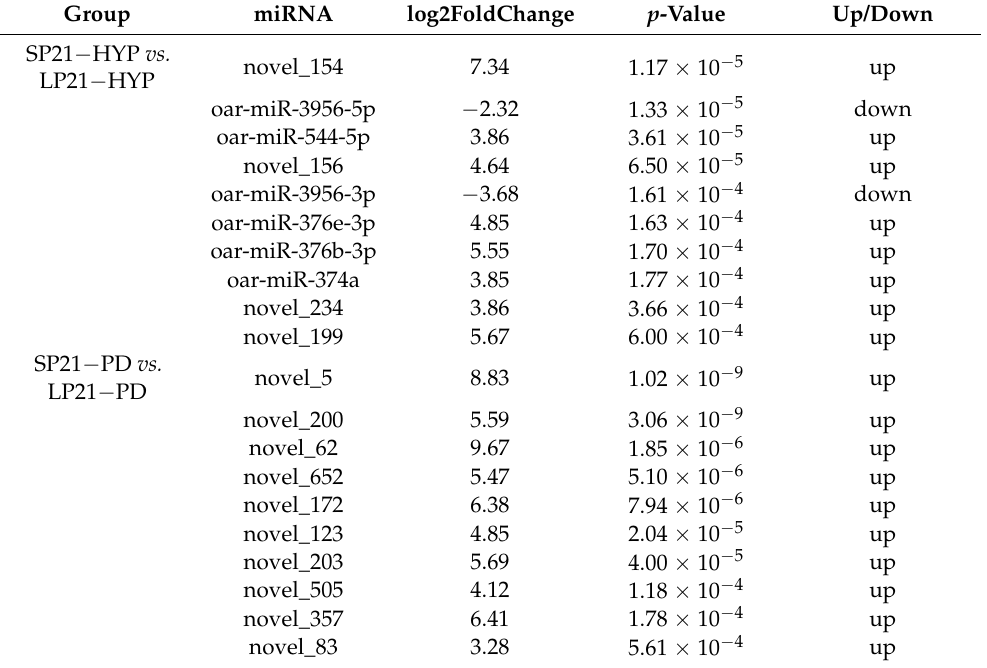
Table 4. miRNAs with the Most Significant Differences in Expression of Hypothalamus and Distal Pituitary. Group miRNA log2FoldChange p -Value Up/Down SP21 − HYP vs. LP21 − HYP